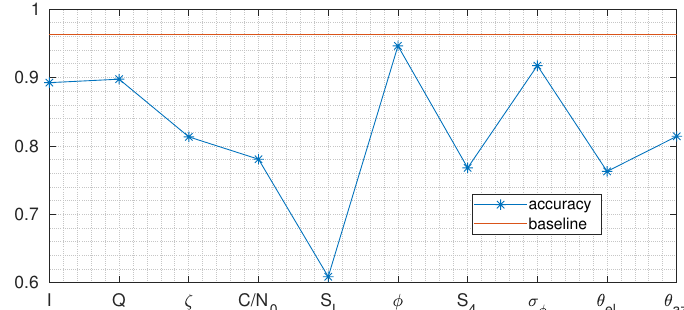
Figure 8. Feature importance analysis using random permutation method. The lower the accuracy with respect to the baseline, the higher the feature